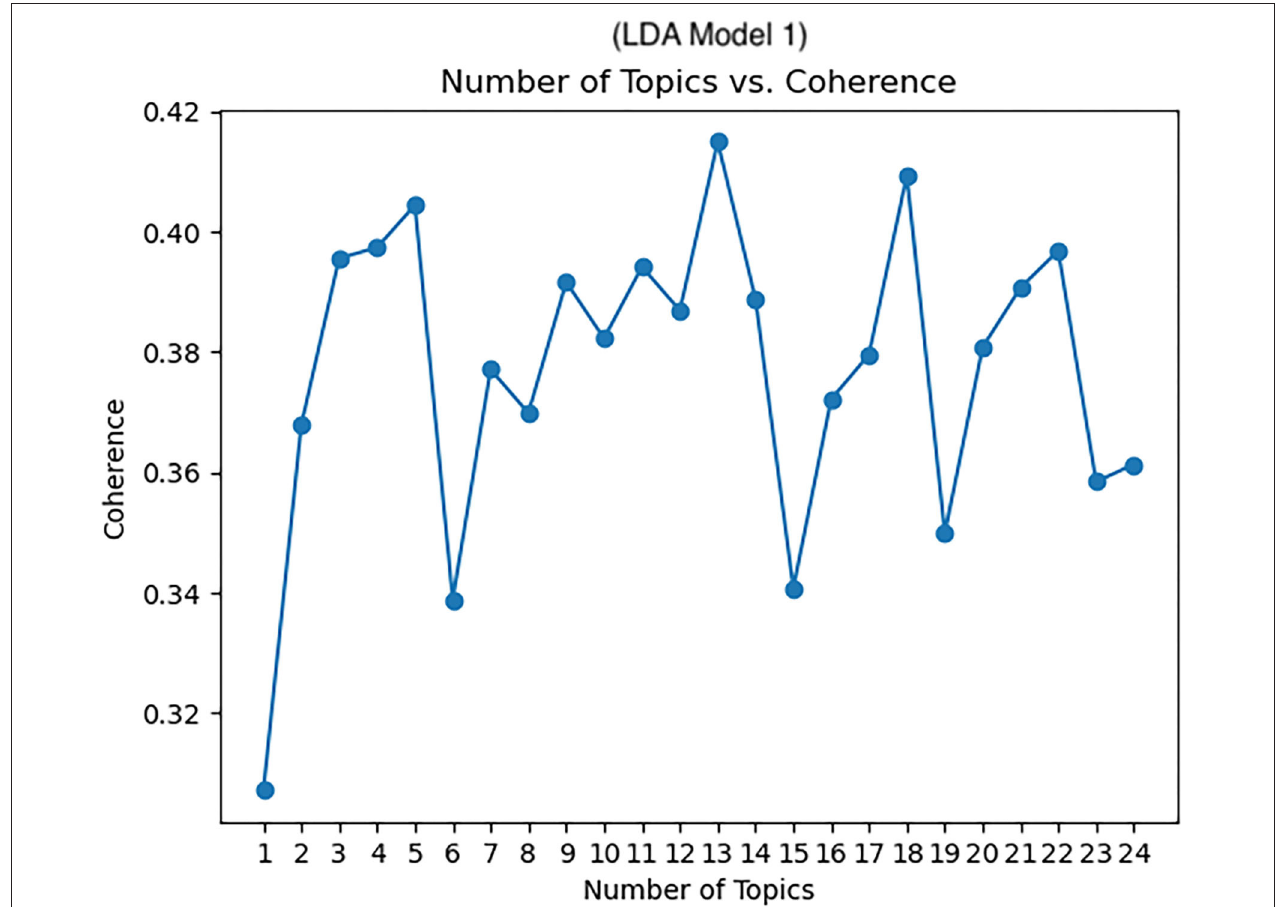
FIGURE 2 | The evaluation results showing the optimal number of topics for highest coherence score for the LDA Model after 50 passes.